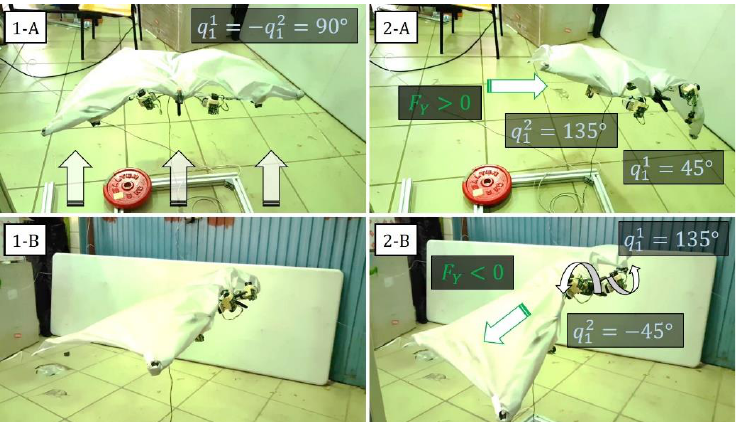
Figure 18. Testbed experiments with wind source showing the lateral force ( 𝐹 𝑌 ) induced due to the rotation of the arms around the shoulder yaw joint. Front view with symmetric pose ( 1-A ) and left arm rotation ( 2-A ). Side view with symmetric pose ( 1-B ) and right arm rotation ( 2-B